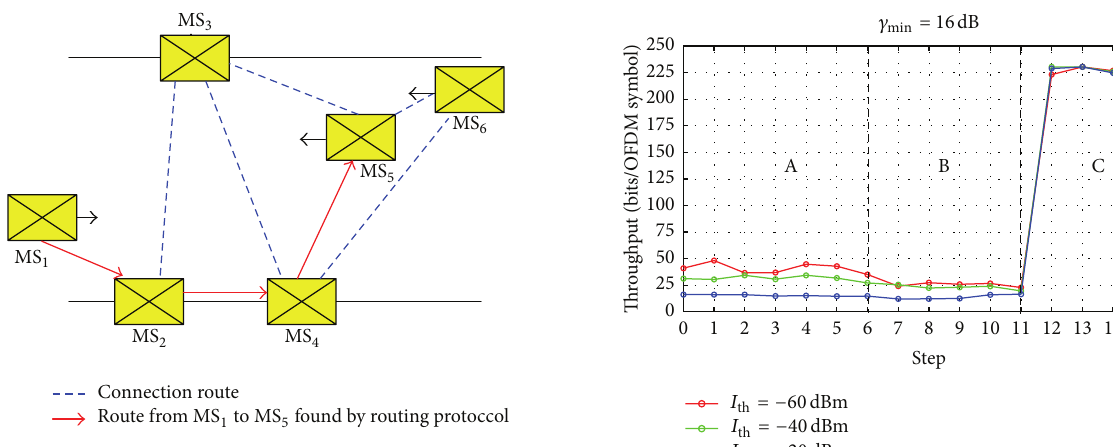
Figure 8: An example of the route from MS 1 to MS 5 .